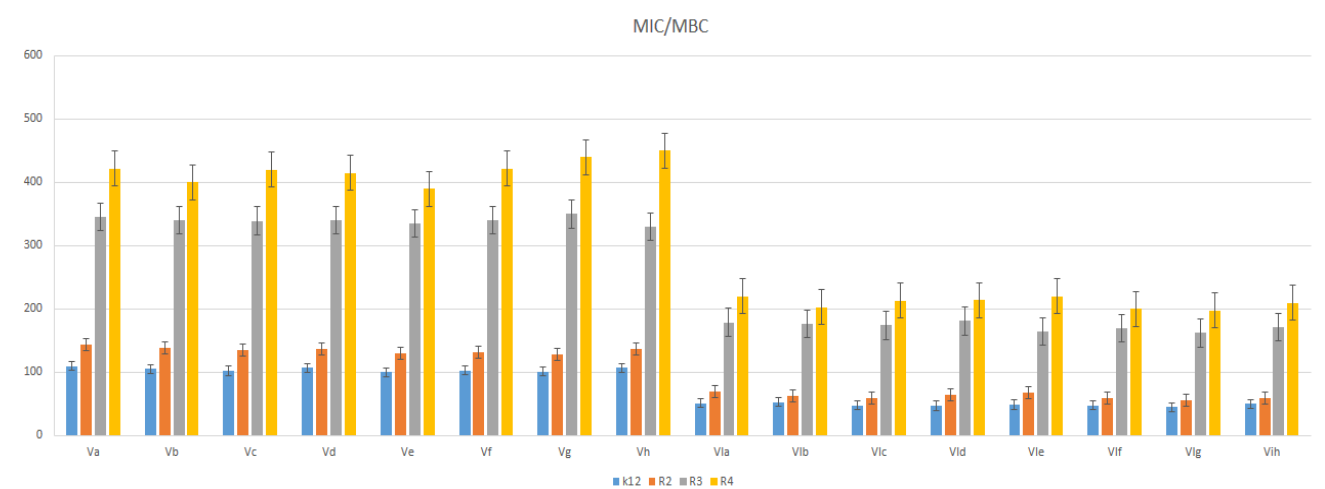
Figure 5. The ratio of MBC/MIC of the phosphonate derivatives. The x -axis features compounds Va–Vh and VIa–VIh used sequentially. The y -axis shows the MIC value. Investigated strains of E. coli K12 as control (blue), R2 strains (orange), R3 strain (grey), and R4 strain (yellow). The y -axis shows the MBC value in μ g/mL − 1 . The order in which the compounds were applied to the plate is shown in Supplementary Materials Figure S1.